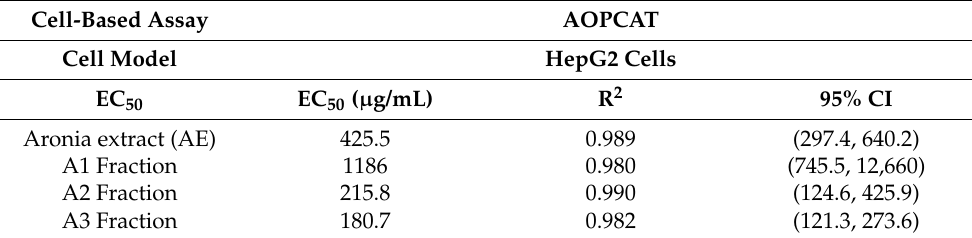
Table 2. EC 50 values for the catalase-like activities of aronia extract and its phenolic fractions assessed with AOPCAT in HepG2 cells. EC 50 values are expressed in micrograms of product per milliliter. The 95% CI represents asymmetrical 95% confidence intervals, and R 2 represents the determination coefficient of the sigmoid regression model fit. There are no statistical differences among EC 50 values marked with the same symbol. All other EC 50 values are statistically different ( p <